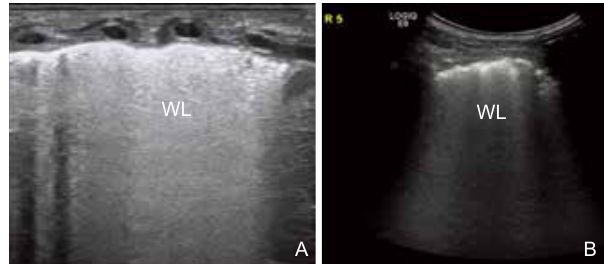
Figure 5 With further aggravation, all the B-lines within the intercostal lung field appear hyperechoic, white and fused, and some even covering the costal acoustic shadow, which is called "white lung" (WL). (A) linear array image; (B) convex array